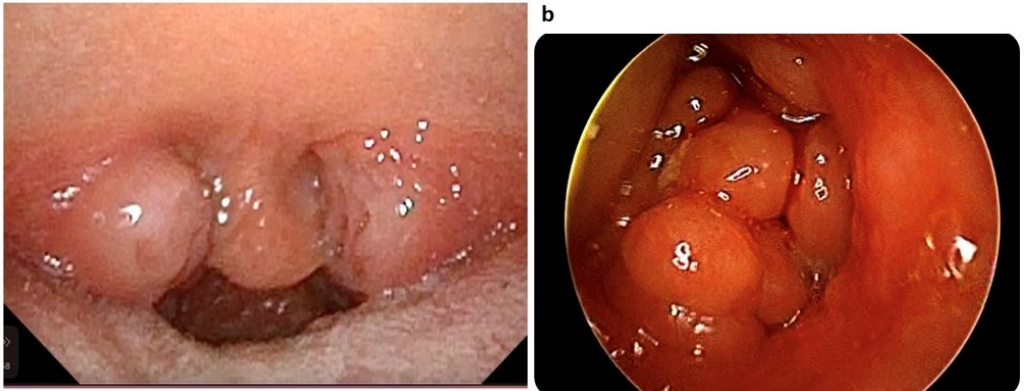
Figure 1. ( a ) Palatine tonsil hypertrophy graded as 3 according to Øverland et al. [14]. ( b ) Adenoid tonsil hypertrophy graded as Grade IV according to Cassano et al. [15].